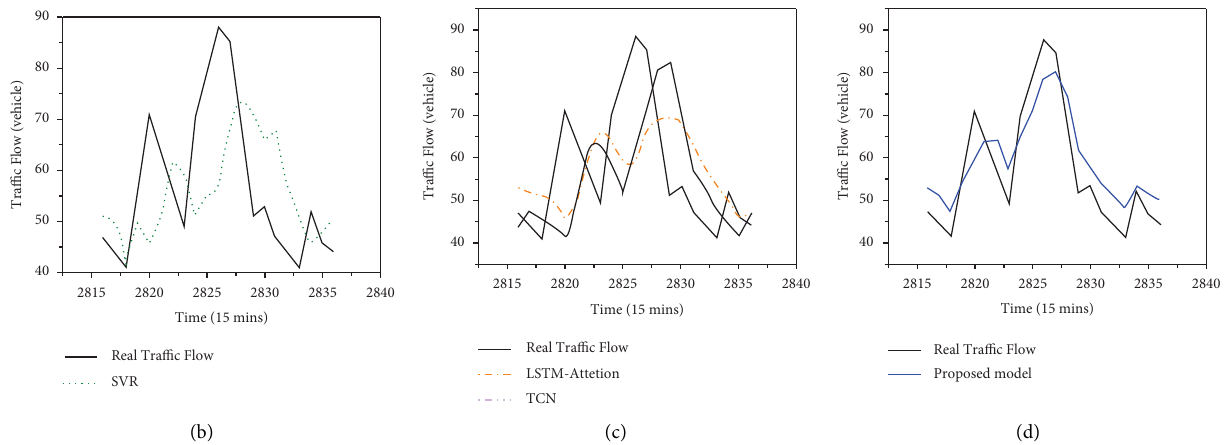
Figure 5: Te trafc fow prediction comparison. (a) Te comparison diagram of the original trafc fow with the proposed model, SVR model, LSTM-attention model, and TCN model; (b) the comparison diagram of the SVR model predicted the trafc fow with real trafc volume; (c) the comparison diagram of the LSTM-attention model with the TCN model and real trafc volume; (d) true time intersection comparison of fux and proposed model predicted